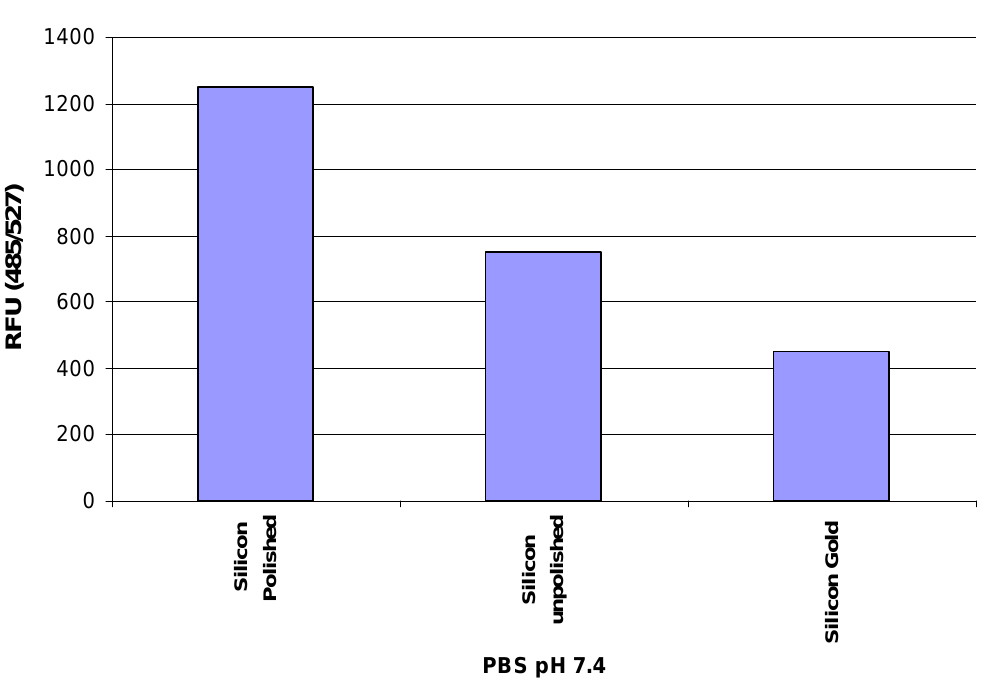
Figure 1: Binding of a fluorescent antibody to different microfluidic supports. Following binding of a FITC-labeled antibody in suspension in PBS to various surfaces, relative fluorescence levels were